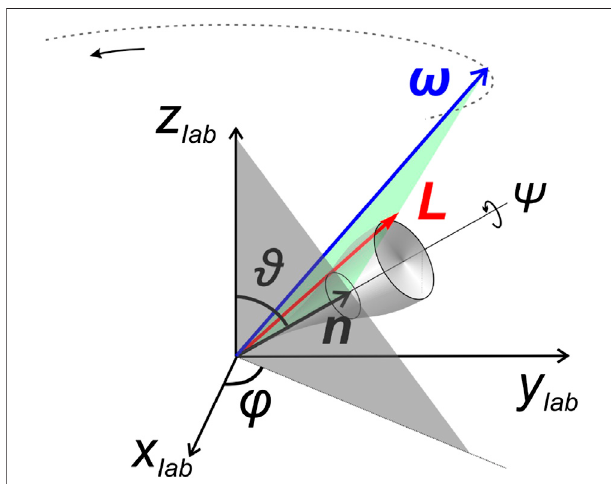
FIGURE 1 | Precessing and nutating heavy top. Angles φ (precession angle), ϑ (nutation angle) and ψ (spinning angle) parametrizing its attitude, the angular momentum, L , and angular velocity, ω . FIGURE 2 | Decomposition of a vector a in the non-orthogonal basis n ,